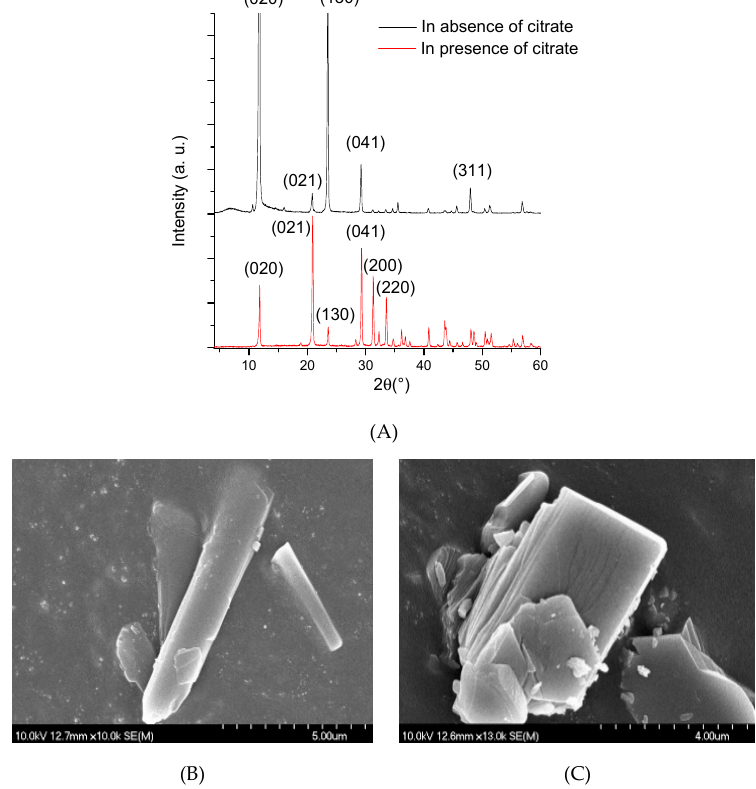
Figure 4. Structural and morphological investigation of gypsum precipitated during the reaction of Na 2 SO 4 + CaCl 2 + 2 H 2 O → 2 NaCl + CaSO 4 · 2H 2 O. ( A ): XRD patterns of gypsum precipitated in the absence and in the presence of citrate (main miller indices were identified using the JCPDS database—CaSO 4 · 2H 2 O: # 21-0816). Bottom: SEM images of gypsum precipitated in absence ( B ) and in presence ( C ) of